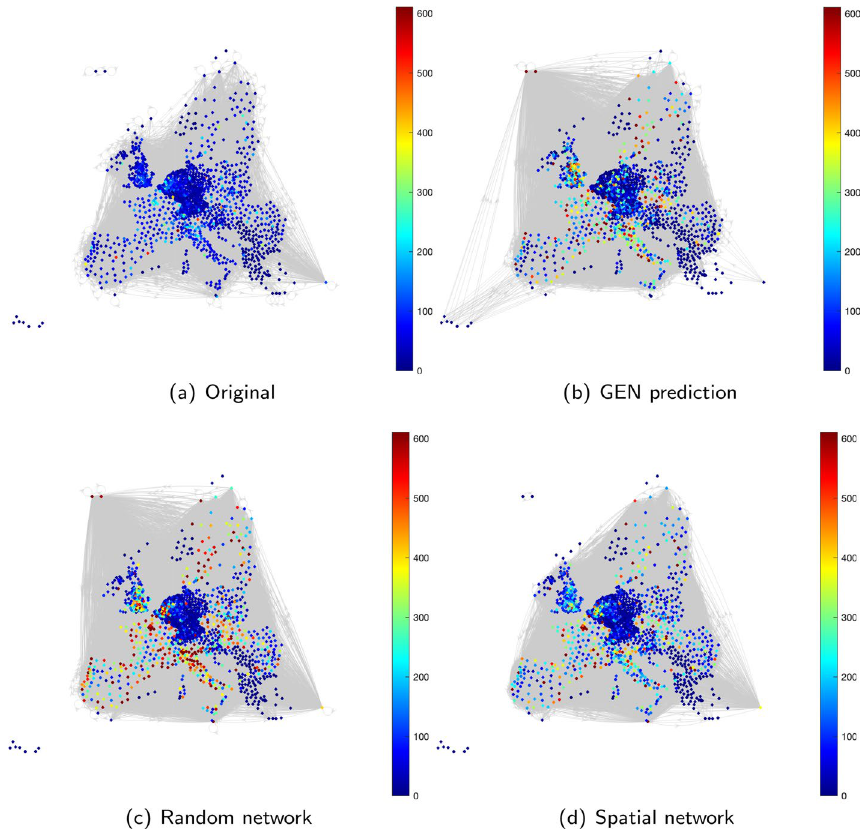
Fig. 3 Predicted network structures and their in-degree centralities